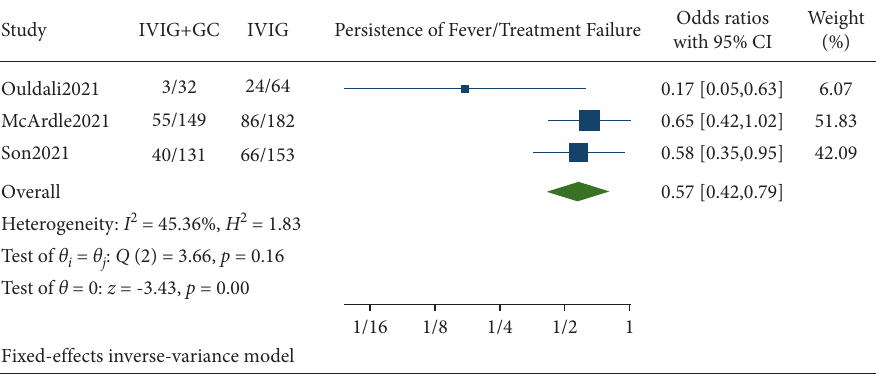
Figure 2: Forest plot showing the comparison of treatment failure/persistence of fever in IVIG plus glucocorticoids versus IVIG.